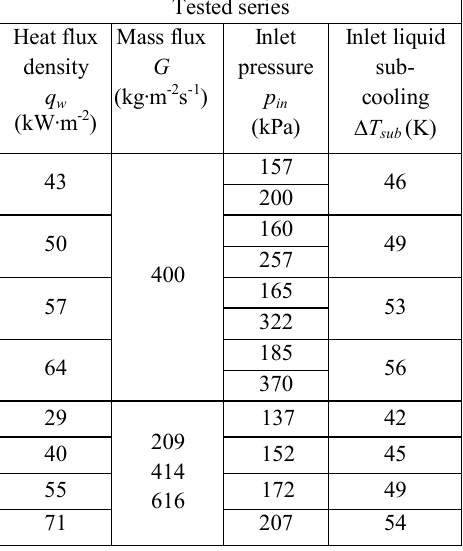
Table 2. Experimental parameters of tested series. Tested series